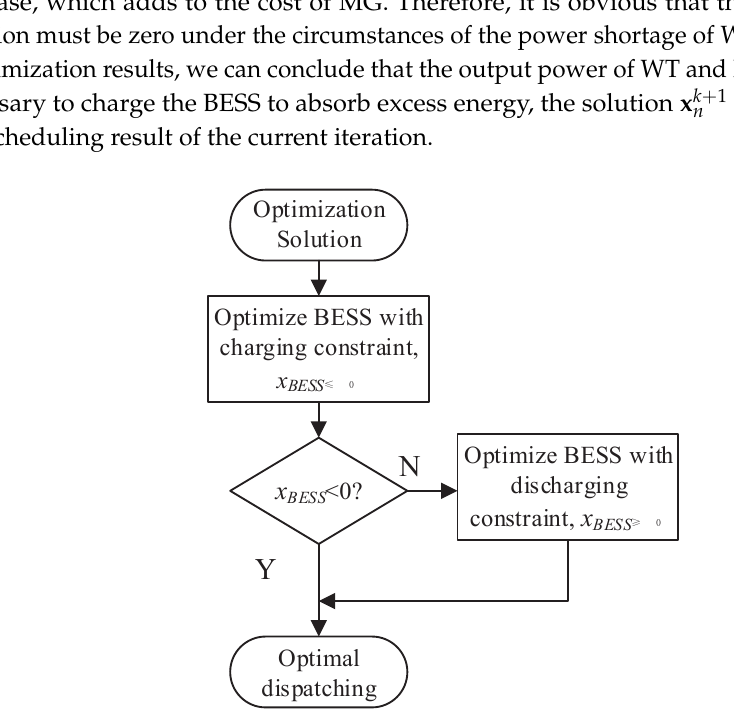
Figure 3. The flowchart of the optimization solution for individual MG. BESS: battery energy storage